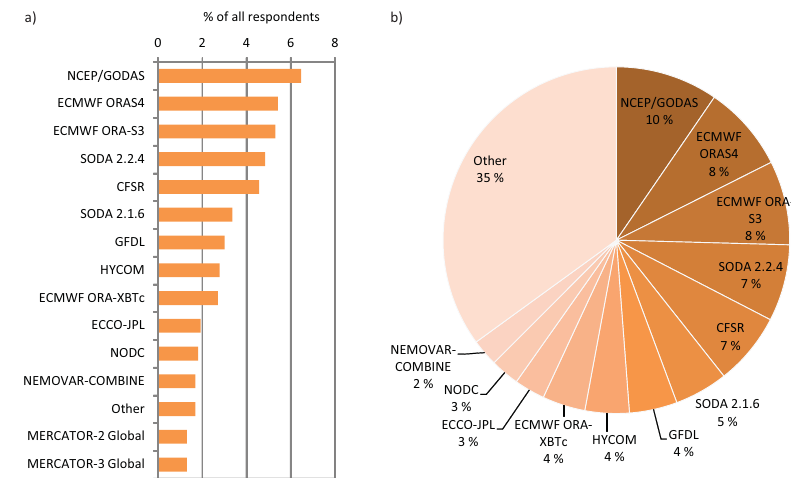
Figure 3. Oceanic reanalysis data sets that the respondents most often used. (a) Percentages of all respondents (2502). Only the 15 most used reanalyses are shown. (b) Percentages of all declared instances of oceanic reanalysis use (1746) given by respondents. The sector “Other” consists of over 40 oceanic reanalysis data sets, whose share from all given votes was less than 2% each. It was asked to choose all that apply.